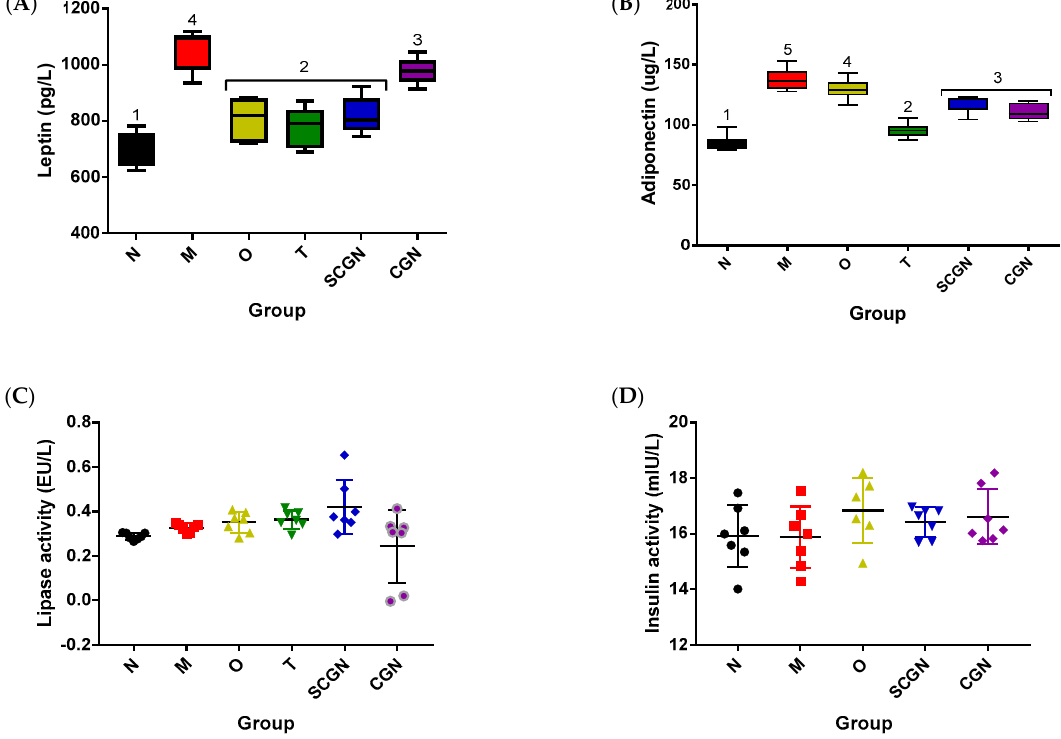
Figure 3. Biochemical analysis of mice sera: ( A ) Leptin level, ( B ) Adiponectin level, ( C ) Lipase level, ( D ) Insulin level. N = Normal, M = Model, O = Orlistat, T = Whole Kappaphycus , CGN = Carrageenan, SCGN = Sans-carrageenan fraction. Values are given as mean ± SEM, n = 7–8. Statistical significances were calculated using one-way ANOVA with Tukey HSD test (numbers denote corresponding homogeneous subsets).